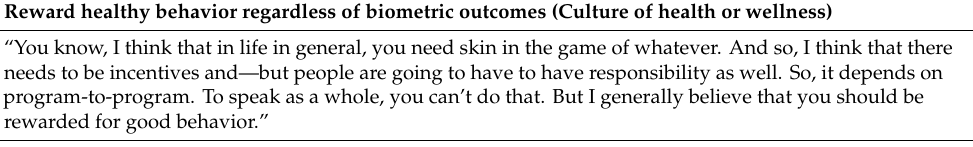
Figure 3. Prevalence of key themes and best practices for employer-sponsored wellness programs. Table 1. Illuminating quotes within key themes and best practices.